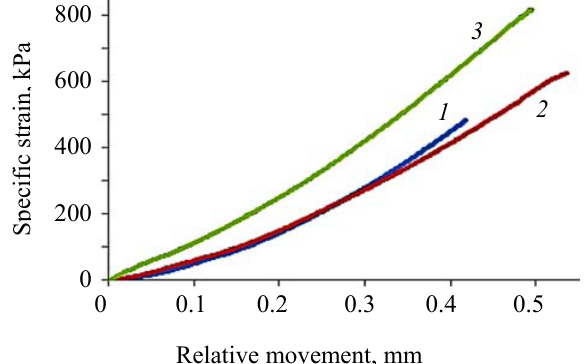
Fig. 1. Loading curves for the compression of fresh carrot samples: ( 1 ) Nantes carrots, ( 2 ) Forto carrots, ( 3 ) Toucheon carrots.